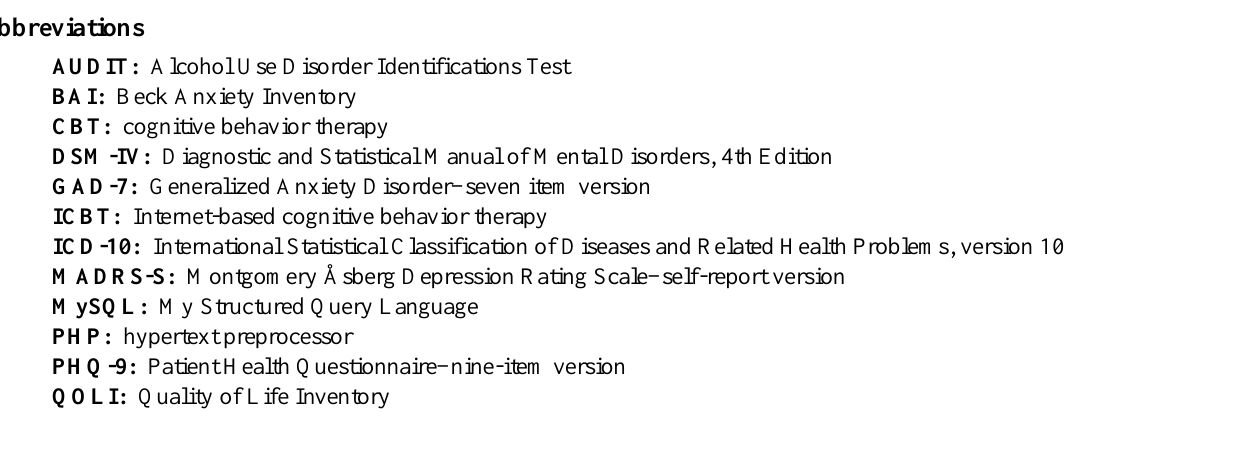
PHQ-9: Patient Health Questionnaire−nine-item version QOLI: Quality of Life